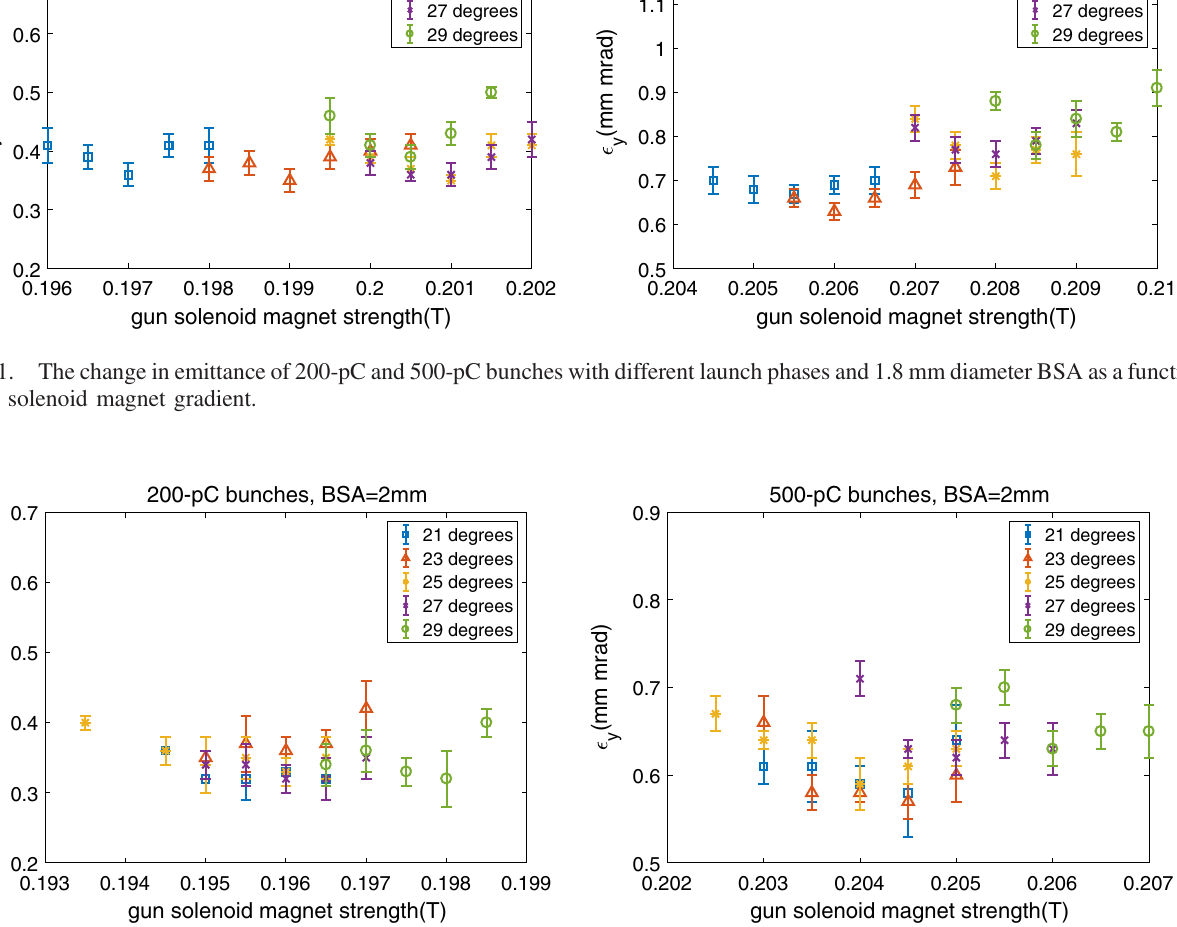
FIG. 12. The change in emittance of 200-pC and 500-pC bunches with different launch phases and 2 mm diameter BSA as a function of gun solenoid magnet